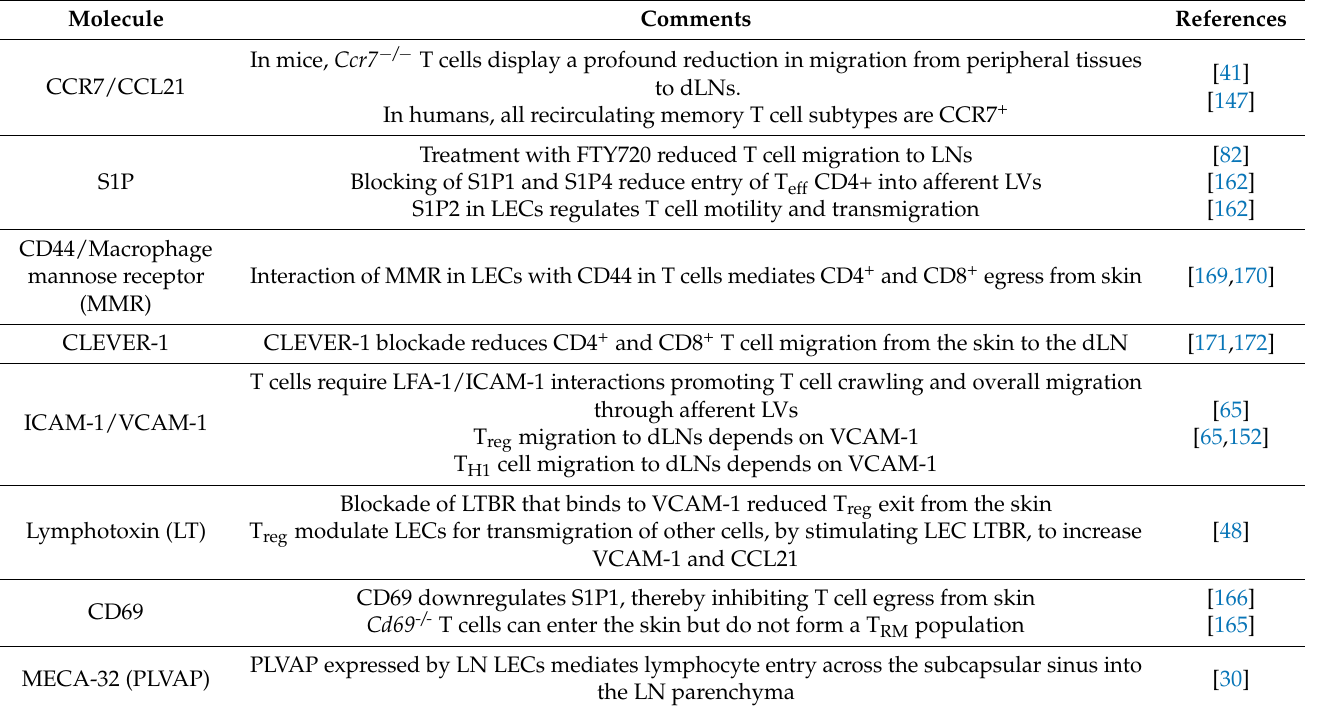
Table 2. Molecules involved in T cell migration through afferent LVs to